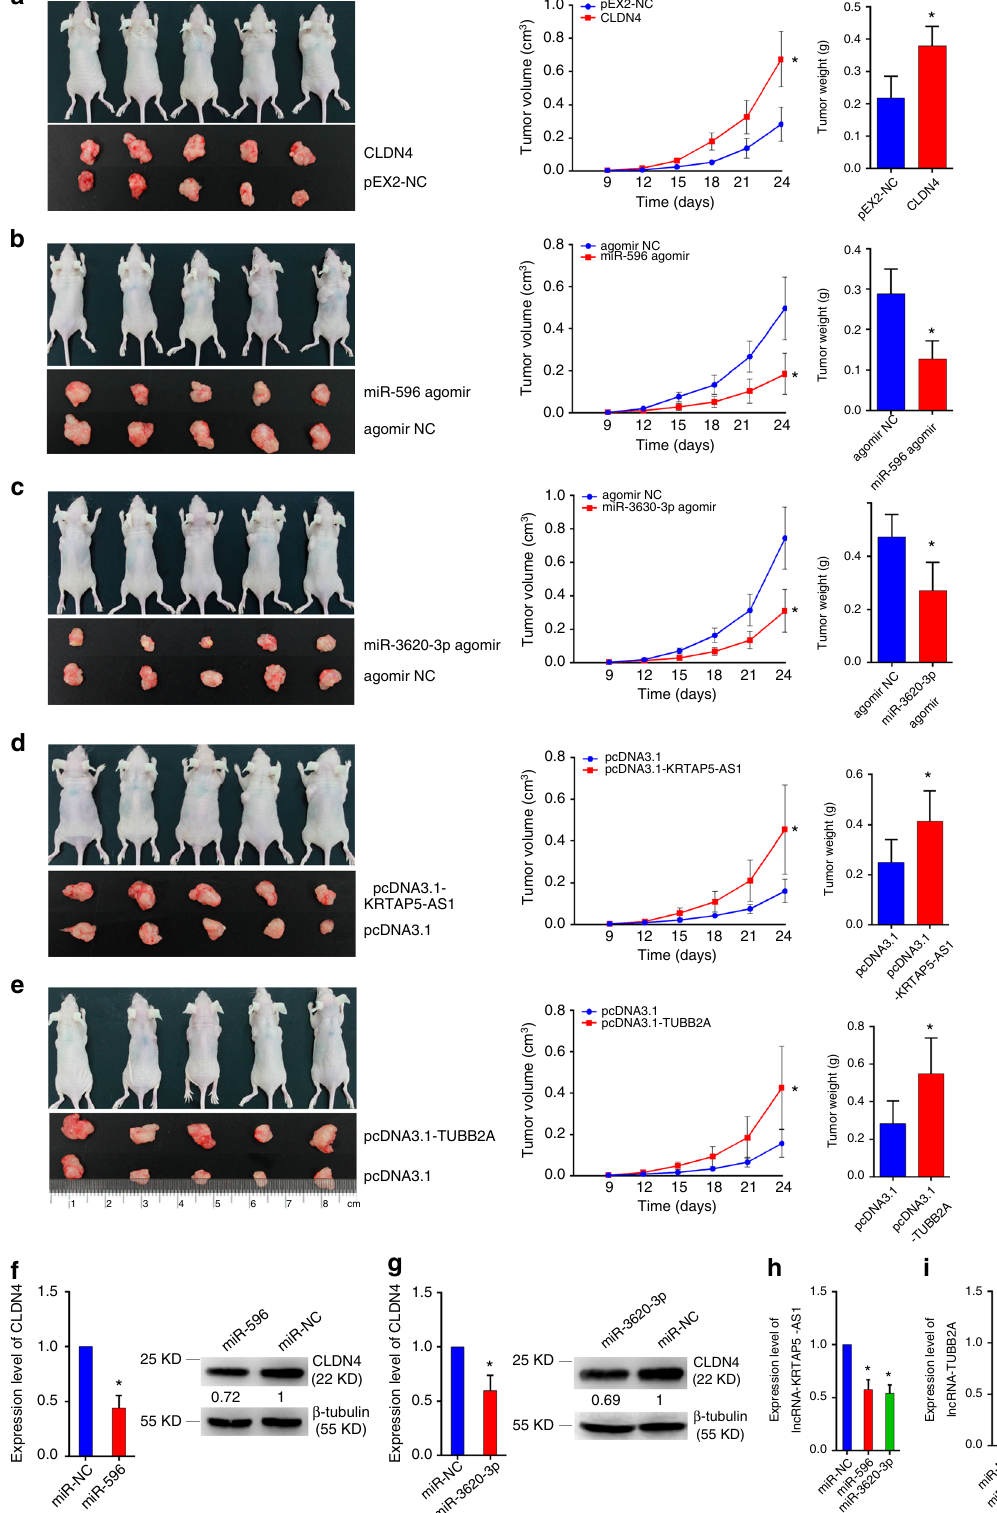
Fig. 8 The effects of CLDN4 and ncRNAs on tumor growth. SGC-7901 cells were subcutaneously injected at both right and left armpit regions of nude mice. After tumor formation, plasmids of CLDN4, lncRNAs and agomirs of miRNAs were injected into tumors of right side and their negative controls into left side . a Treatment of CLDN4 promoted xenograft tumor growth. b , c Treatment of miR-596 and miR-3620-3p suppressed xenograft tumor growth. d , e Treatment of pcDNA3.1-KRTAP5-AS1 and pcDNA3.1-TUBB2A promoted xenograft tumor growth. f , g miR-596 and miR-3620-3p treated tumors showed less CLDN4 expression. h miR-596 and miR-3620-3p treated tumors showed less IncRNA-KRTAP5-AS1 expression. i miR-3620-3p treated tumors showed less IncRNA-TUBB2A expression. Data are shown as mean ± s.d., n = 5 for each group. The data statistical signi fi cance is assessed by Student ’ s t -test. * P < 0.05, ** P <